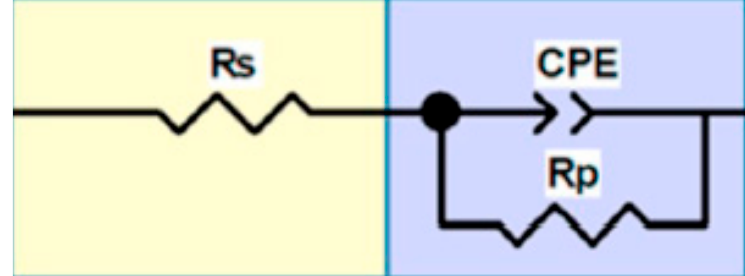
Figure 6. Randle equivalent circuit diagram. Table 6. Fitted parameters obtained from the EIS plots.